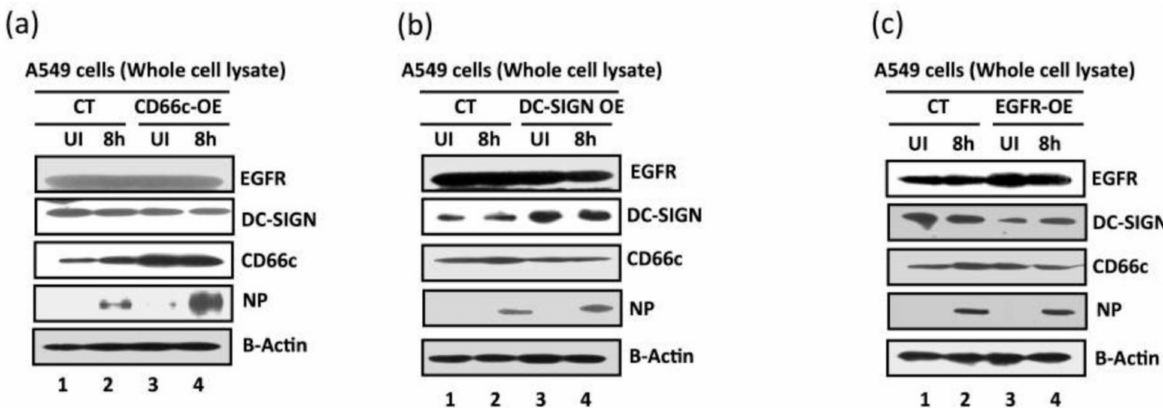
Figure 11. Comparative measurement of viral infection in cells overexpressing CD66c, EGFR and DC-SIGN respectively. CT, control A549 cells (untransfected) with endogenous levels of protein expression; CD66c-OE is A549 cells overexpressing CD66c; DC-SIGN-OE, A549 cells overexpressing DC-SIGN; EGFR-OE, A549 cells overexpressing EGFR; UI, uninfected cell groups; 8 h, cells harvested after 8 h of A/PR8/34 influenza virus infection. ( a ) The A549 cells overexpressing CD66c (CD66c-OE) demonstrate significantly increased virus entry as against A549 cells with endogenous levels of CD66c (CT) when determined by the expression levels of viral protein NP (fourth panel from top). Top two panels in figure also show that overexpression of CD66c has not affected expression levels of EGFR and DC-SIGN, and their expression levels remained same as in untransfected A549 cells (top two panels). β -Actin is loading control. ( b ): cells overexpressing DC-SIGN (DC-SIGN-OE) showed a slight increase in virus entry into cells as against A549 cells with endogenous levels of DC-SIGN (CT), when determined by the level of viral NP protein (fourth panel from top). More importantly, overexpression of DC-SIGN has not increased expression levels of EGFR and CD66c, whose levels remained same as in untransfected A549 cells (top and third panel from top). β -Actin is loading control here. ( c ): The expression levels of viral NP protein (fourth panel from top) suggests that overexpression of EGFR in A549 cells (EGRF-OE) does not result in further increase in virus entry. The virus entry in these cells is same as in A549 cells with endogenous levels of EGFR (CT). Accordingly, overexpression of EGFR does not increase expression levels of DC-SIGN and CD66c (second and third panel from top). β -Actin is loading